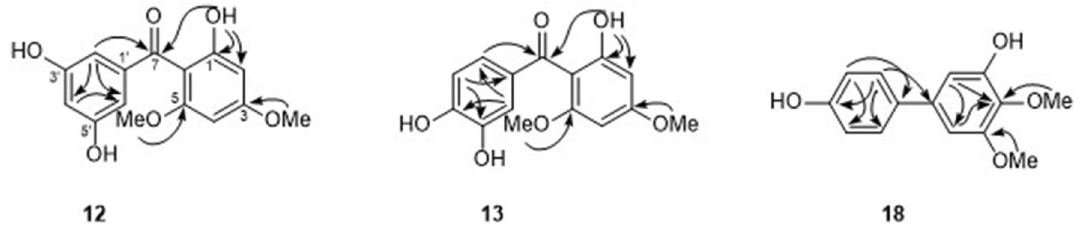
Figure 2. Key HMBC correlations of compounds 12 , 13 and 18